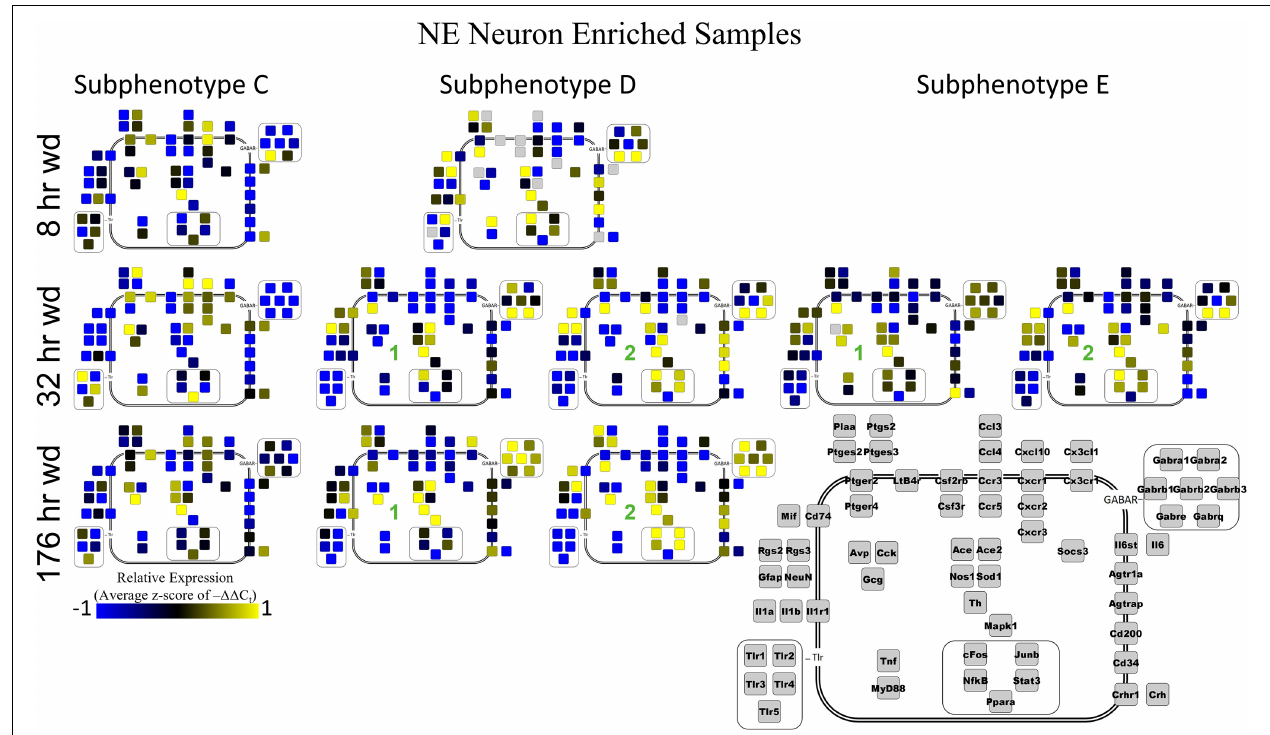
FIGURE 6 | Subphenotype Gene Expression in Norepinephrine Neuron Enriched Samples. Cellular diagrams display boxes representing relative gene expression (average z-score of – (cid:49)(cid:49) C t values) of subphenotypes shown in prior heatmaps. Legend with gray boxes in lower right labels which boxes correspond to which gene. Box color represents expression (blue is low expression and yellow is high expression). The location of the box represents the localization or function of the protein product from that gene transcript. Green numbers indicate subgroups within subphenotypes. Groups A and B shown in Supplementary Figure 5